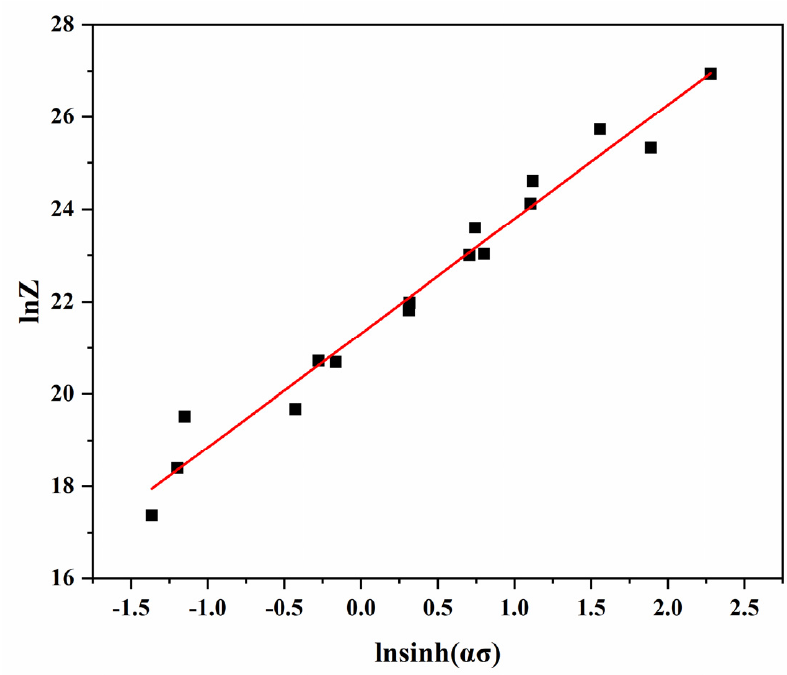
Figure 7. The linear fitting curve of lnZ − ln [ sinh ( ασ )]